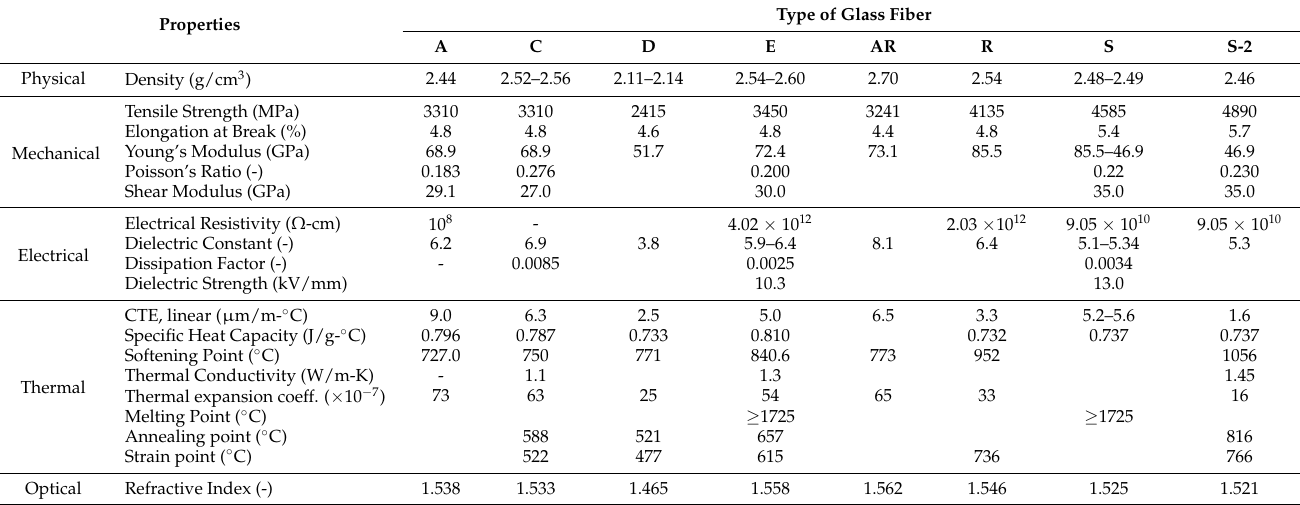
Table 2. Main physical, mechanical, electrical, thermal and optical properties of glass fibers [35–39].